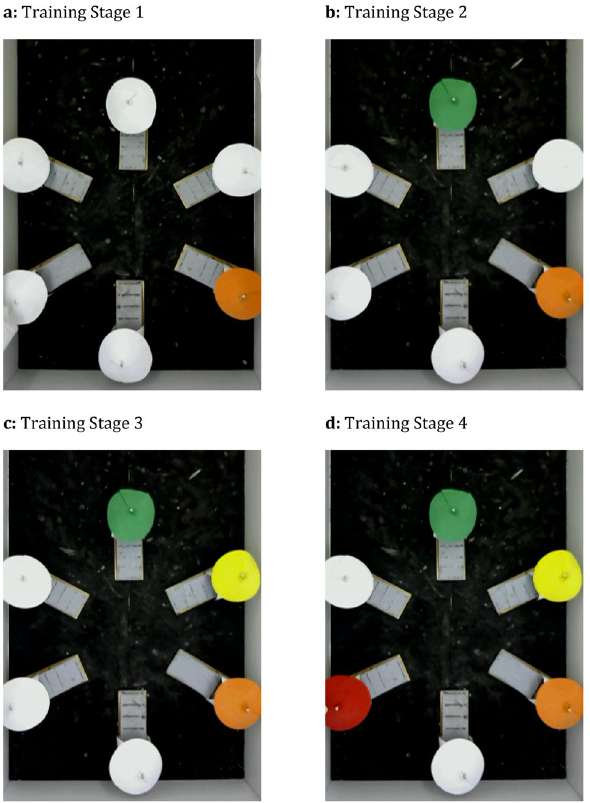
Figure 2. Examples of a trial in each memory training stage. The location of each sequence item (coloured feeder) changed between trials as to not systematically reinforce a certain location. The sequence shown here is for illustrative